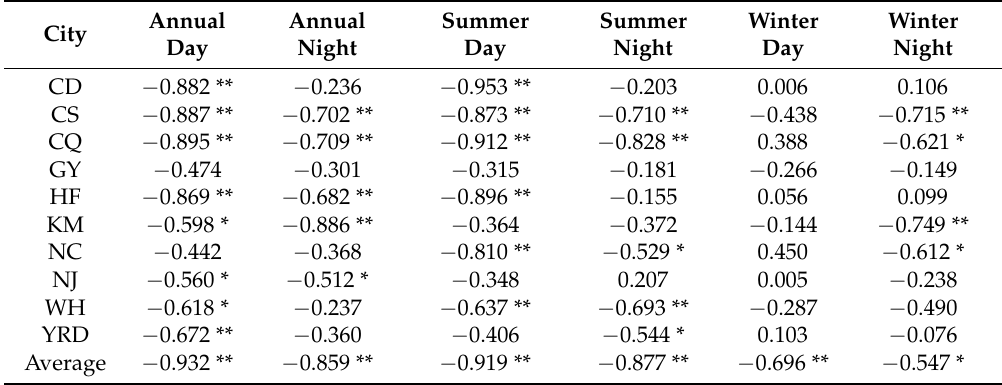
Table 8. Correlation analyses between SUHII and ∆ EVI at 10 cities in YRB, China.